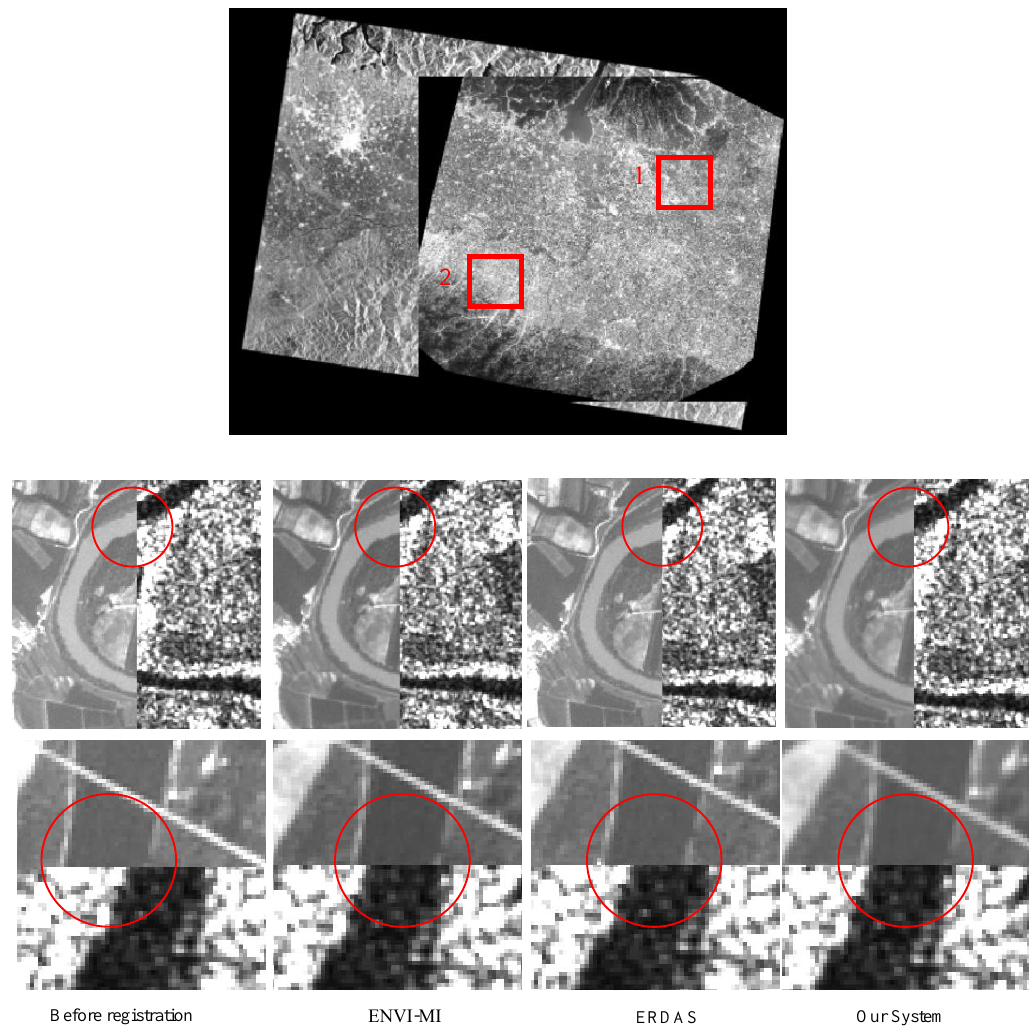
Figure 7 Registration results of before registration, ENVI-MI, ERDAS, and our system. Line 1 shows the registration results in the overlapping area of SAR and optical images. Line 2 shows the enlarged registration results in box 1. Line 3 shows the enlarged registration results in box